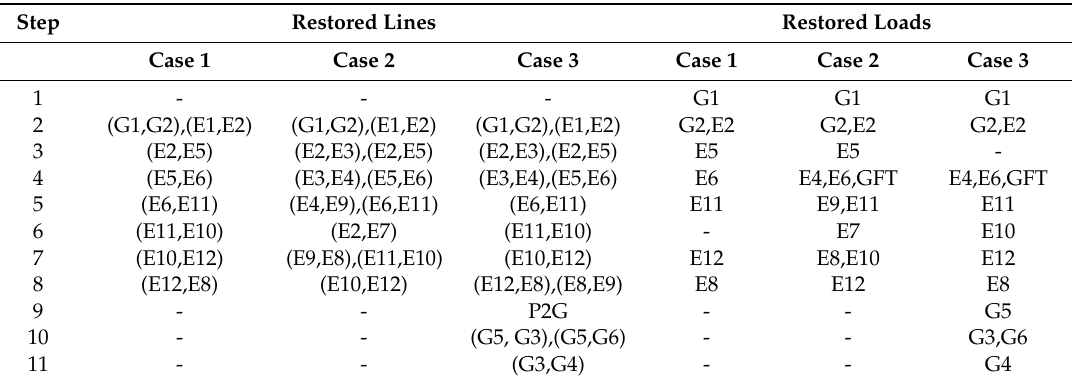
Table 9. Restoration actions of the three